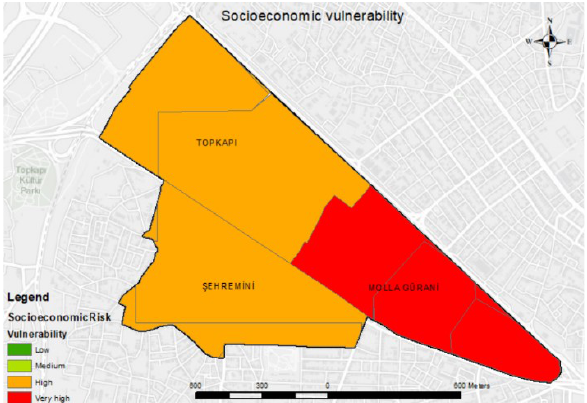
Figure 3 . Socioeconomic vulnerability. Source: de Vries,